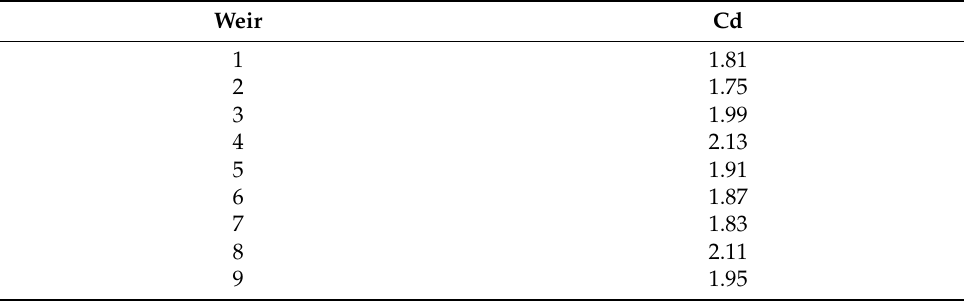
Table 2. Estimated discharge coefficient for each of the